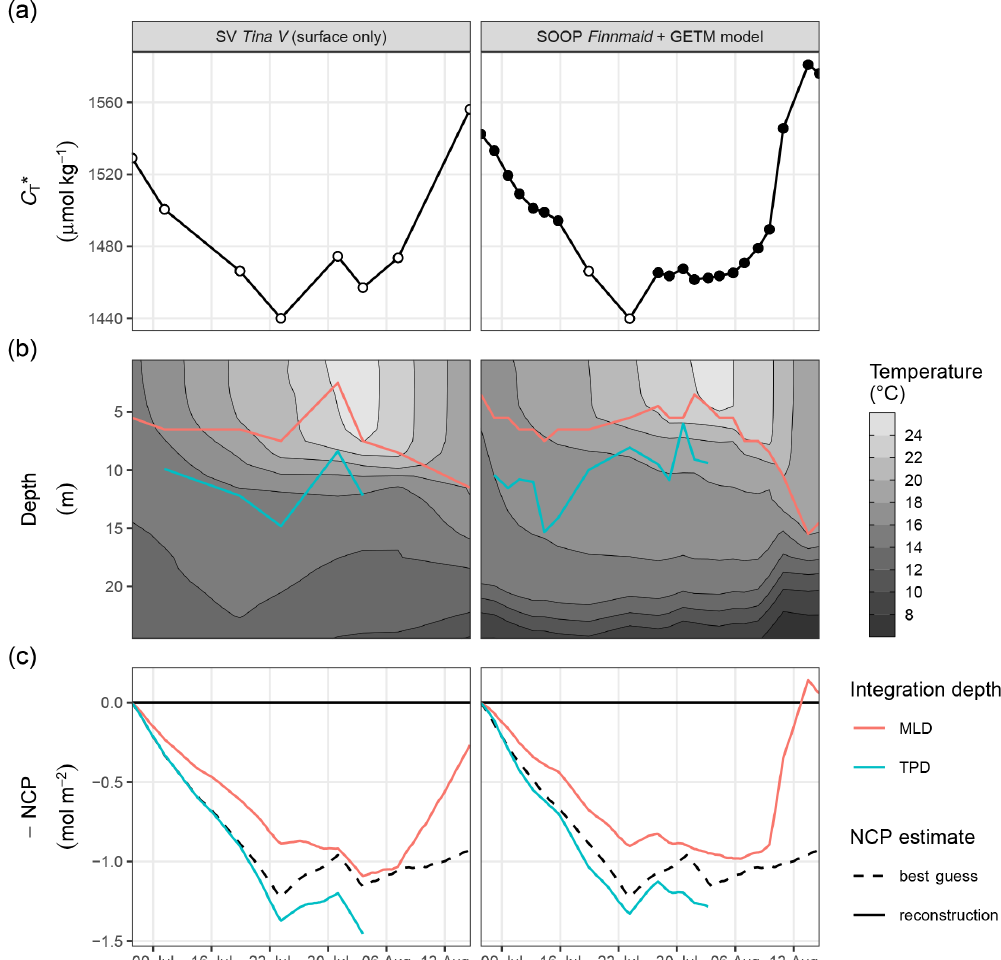
Figure 6. Time series illustrating the reconstruction of depth-integrated NCP from surface C ∗ rameters. Displayed are results based on two test data sets, namely observations from SV Tina V without C ∗ a combination of SOOP C ∗ and modelled hydrographical data (right panels). From top to bottom, panels represent (a) surface C ∗ T vertical distribution of temperature together with the mixed-layer depth (MLD) and temperature penetration depth (TPD) for each cruise day, and (c) depth-integrated NCP comparing the reconstructions (solid lines) with the best guess (dashed black line) according to Fig. 5. Please note that a data gap in the SOOP record was filled with two observations from SV Tina V (open circles in a